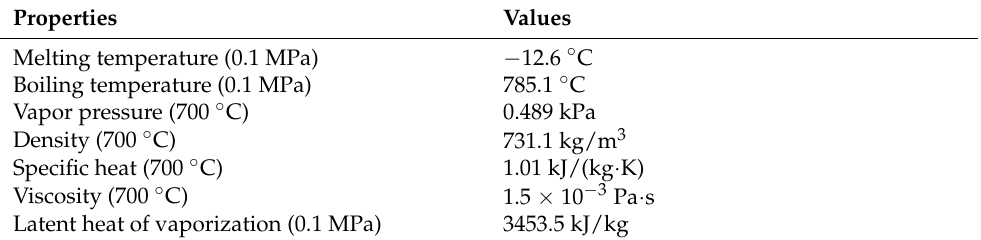
Table 1. Thermophysical properties of the Na-K (77.8% by mass of potassium) alloy.